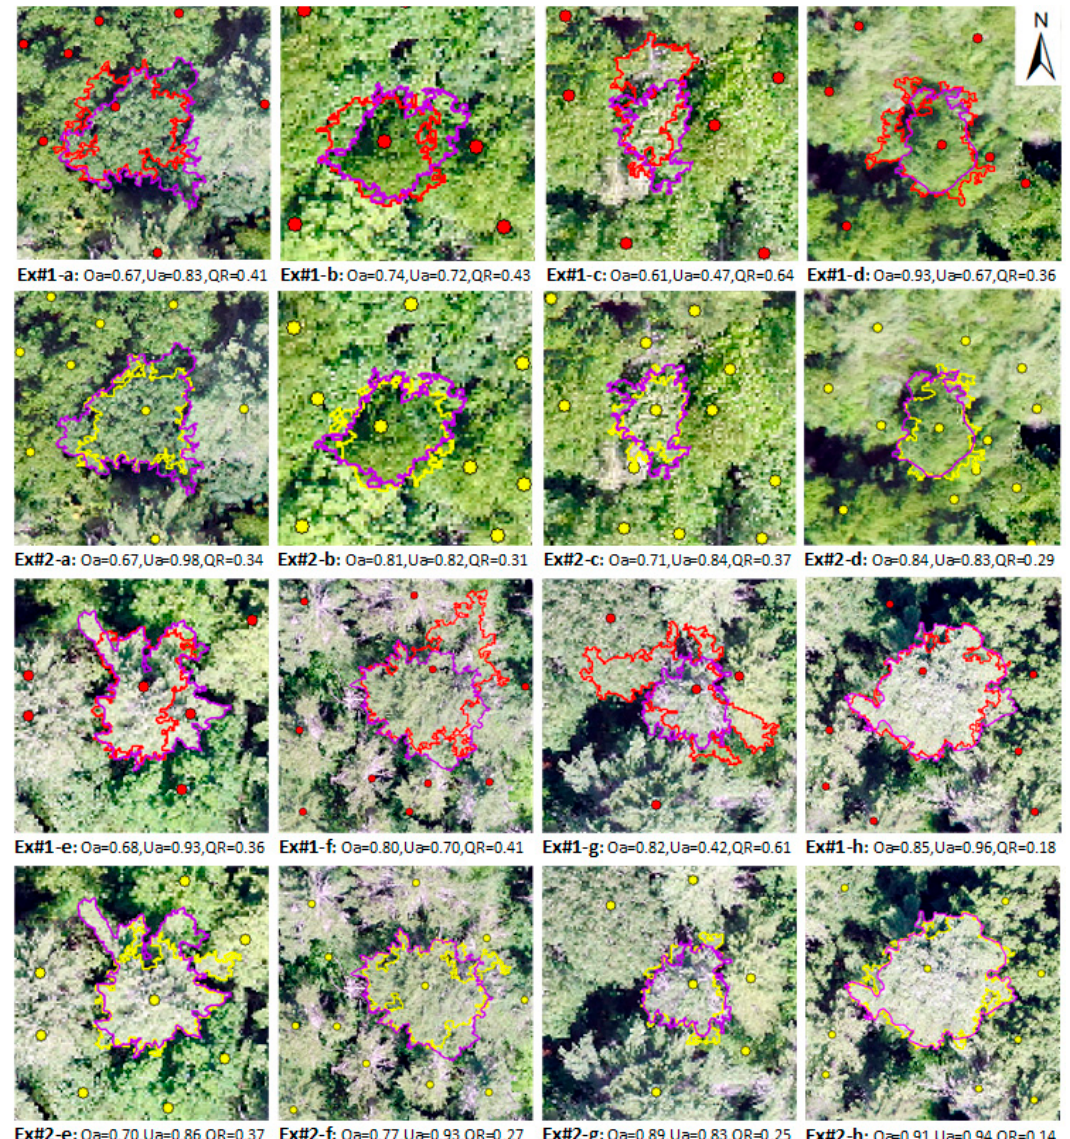
Figure 5. Comparison of the results of experiment #1 and #2 with the reference crowns for eight individual trees (a-h).